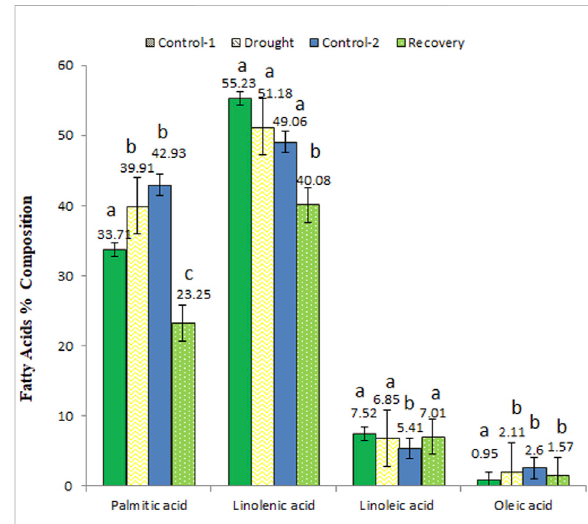
FIGURE 6 The variations in percent composition of common fatty acids detected in control, drought-stressed, and post-drought recovery plants. Different letters above the column indicate signi fi cant changes when determined through Tukey ’ s HSD